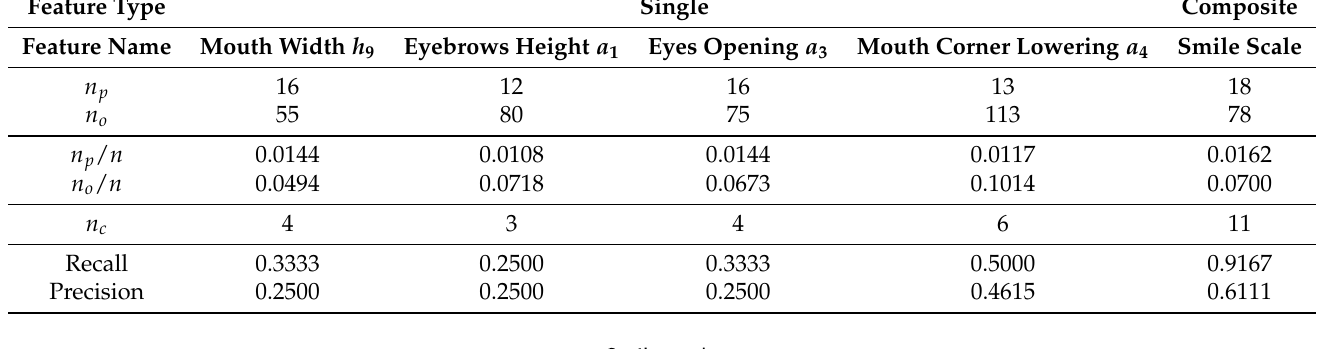
Table 2. Various parameters and ratios measured (test data: number of whole data n = 1114, number of event points n e = 12). Feature Type Single Composite